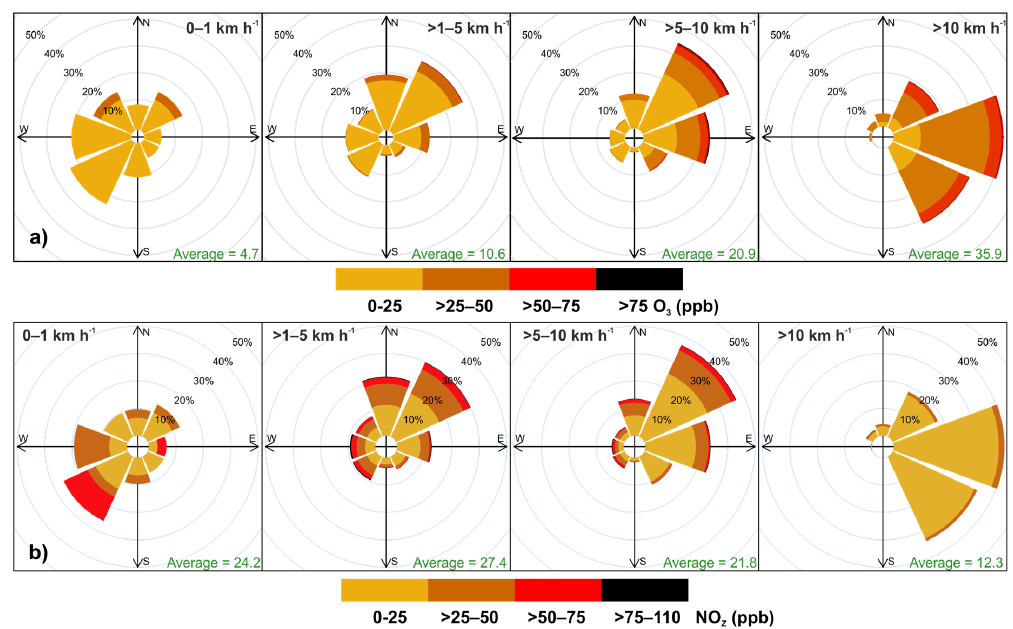
Figure 6. ( a ) Pollution roses of 1-h O 3 averages and ( b ) pollution roses of NO z by wind speed (WS) recorded at the OBI site from September 2012–September